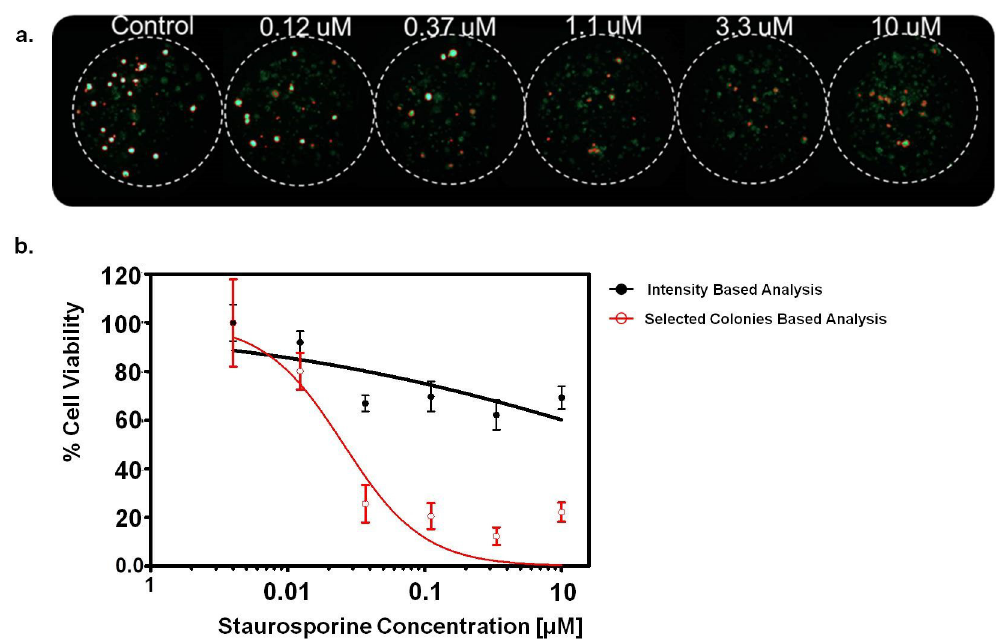
Fig 3. Alginate spot images (a) and dose response curve (b) of #5 patient-derived cancer cell line with staurosporine. (a) Red marks in alginate spot images are the selected colonies by the optimal intensity threshold. The image of an alginate spot in 10 uM staurosporine showed 8% of viable cells, while the control with established cell line has 100% cell viability. (b) Even though 10 uM staurosporine affected cell viability of #5 PDC, high amount of debris and cells with low viability resulted in a large intensity offset and increased cell viability in the dose response curve. But, in the selected colony area method, the cell viability was reduced to 30% upon 10uM staurosporine treatment compared to the